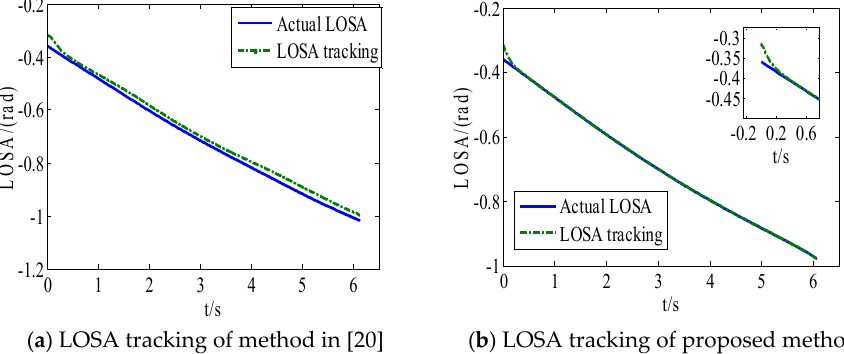
Figure 13. Line of sight angle (LOSA) tracking contrast.